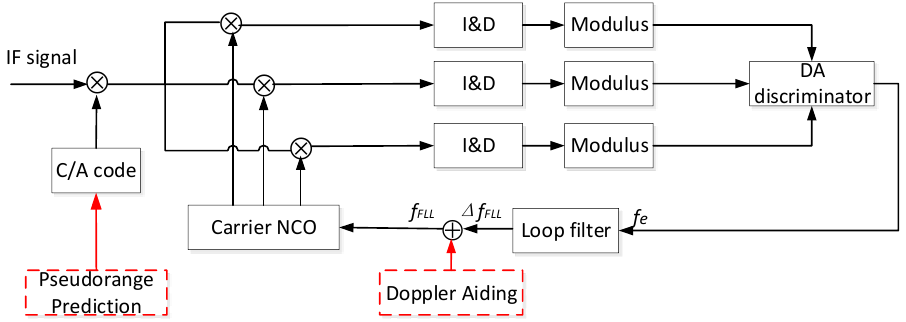
Figure 4. Frequency-locked loop (FLL) structure based on a DA frequency discriminator.